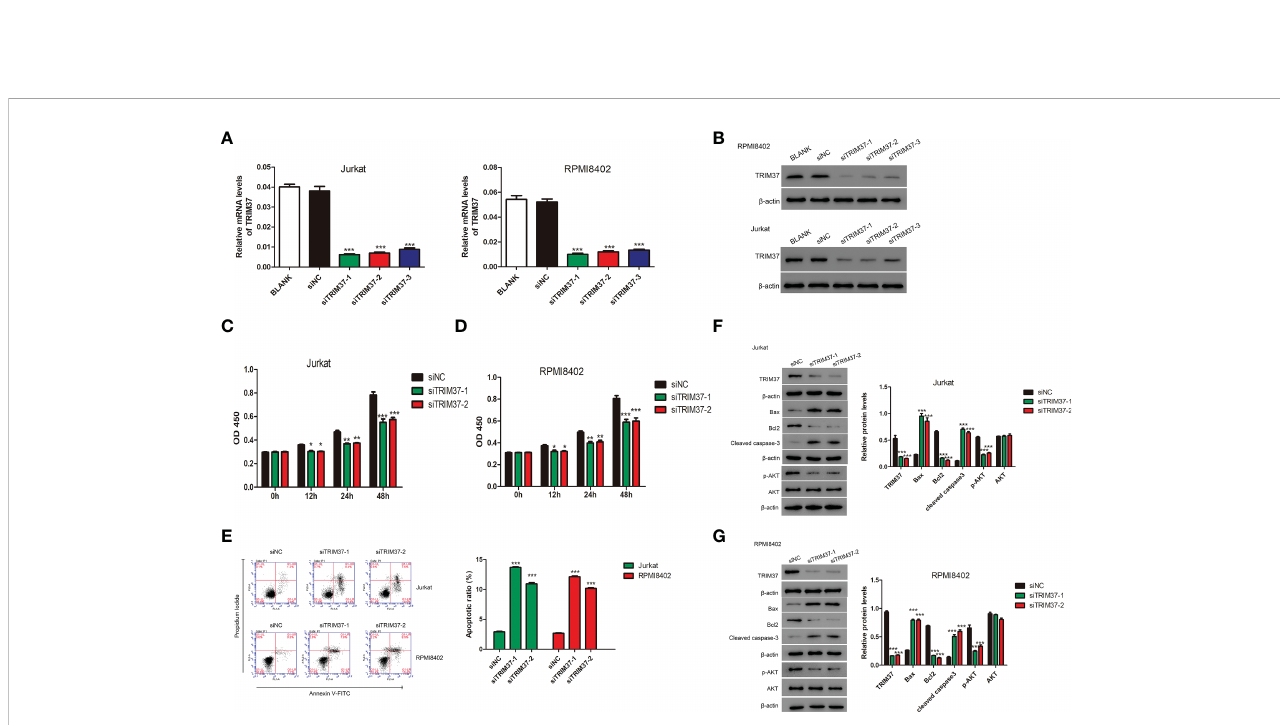
FIGURE 2 TRIM37 silencing suppressed the growth of human T-ALL cells. (A, B) The knockdown ef fi ciency of siRNAs targeting TRIM37 was quanti fi ed by qRT-PCR and Western blotting. *** p < 0.001, compared with siNC group. (C, D) The CCK-8 assays for cell growth detection of Jurkat and RPMI8402 cells. * p < 0.05 compared with siNC group, ** p < 0.01 compared with siNC group, *** p < 0.001 compared with siNC group. (E) Flow cytometry assays were performed to evaluate the apoptosis of Jurkat and RPMI8402 cells. *** p < 0.001, compared with siNC. (F, G) Western blotting was employed to examine the protein contents of TRIM37, Bax, Bcl2, cleaved caspase 3, p-AKT, and AKT in Jurkat and RPMI8402 cells transfected with/or without siTRIM37-1 or siTRIM37-2. *** p < 0.001, compared with siNC.